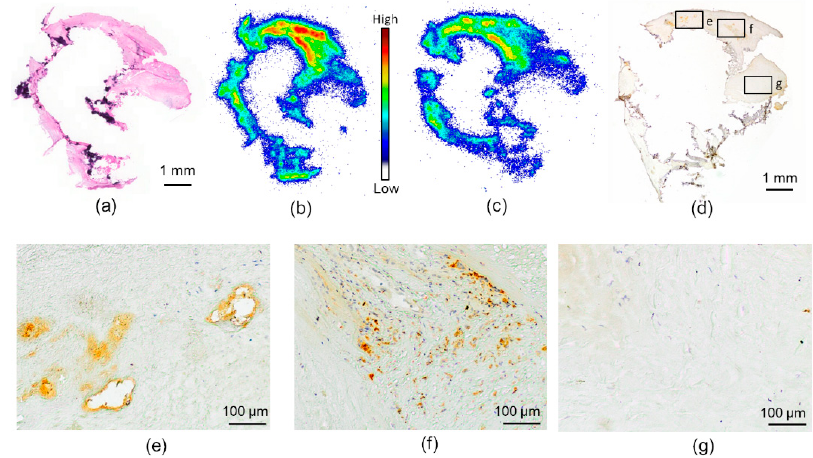
Figure 2. [ 18 F]Flutemetamol in vitro autoradiography of human carotid atherosclerotic plaque. ( a ) ( a ) Hematoxylin-eosin-stained section of human carotid endarterectomy sample. Calcified areas